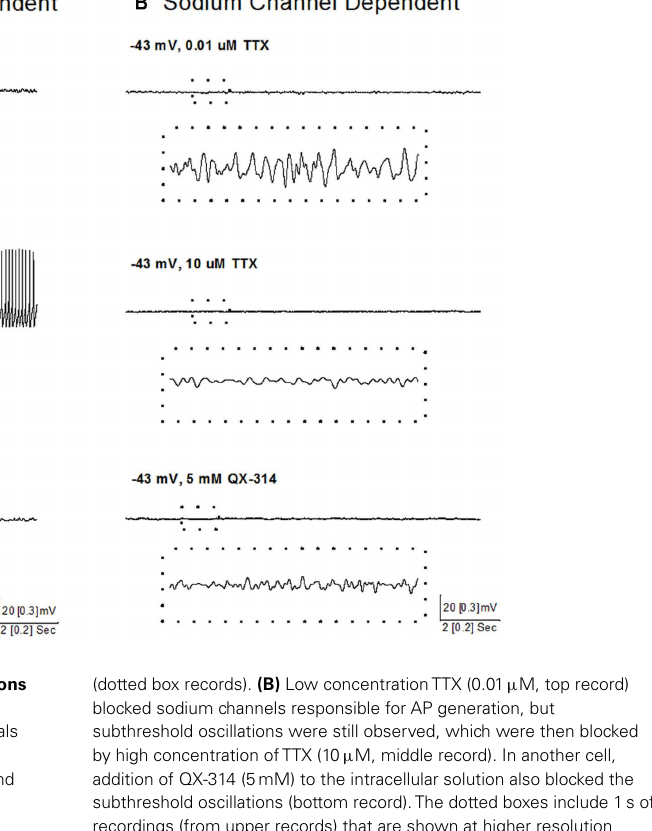
(dotted box records). (B) Low concentrationTTX (0.01 μ M, top record) blocked sodium channels responsible for AP generation, but subthreshold oscillations were still observed, which were then blocked by high concentration ofTTX (10 μ M, middle record). In another cell, addition of QX-314 (5mM) to the intracellular solution also blocked the subthreshold oscillations (bottom record).The dotted boxes include 1s of recordings (from upper records) that are shown at higher resolution (dotted box